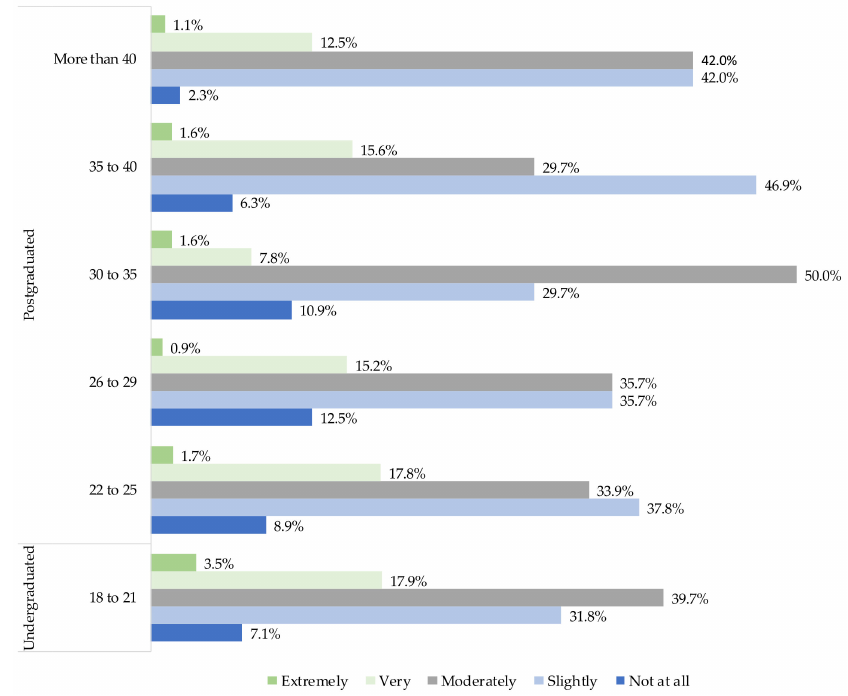
Figure 5. Percentages showing level of trust declared by participants in slot